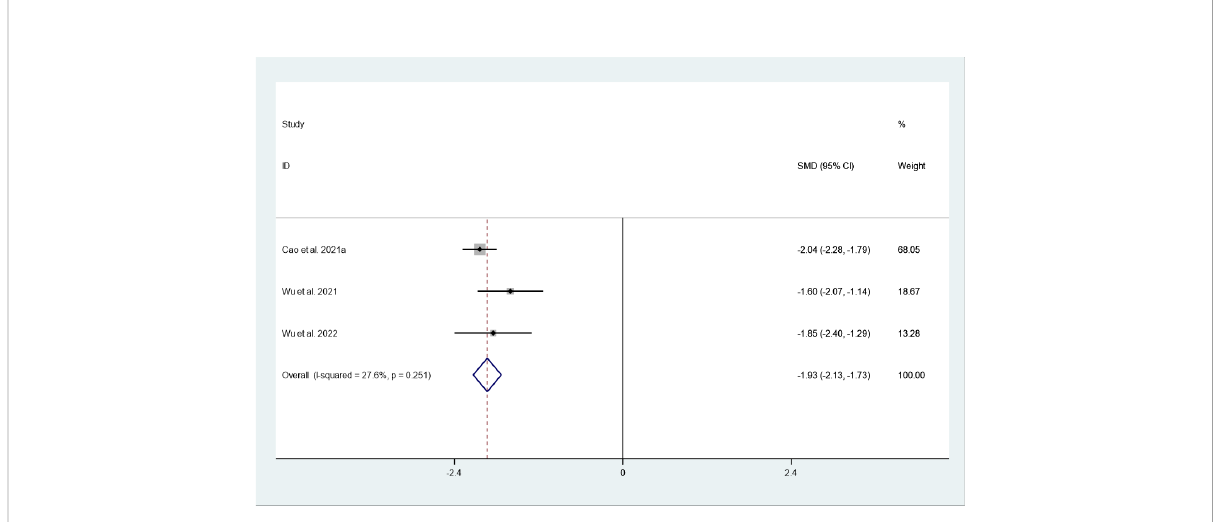
FIGURE 3 Changes in maximum diameter after thermal ablation at 3-year